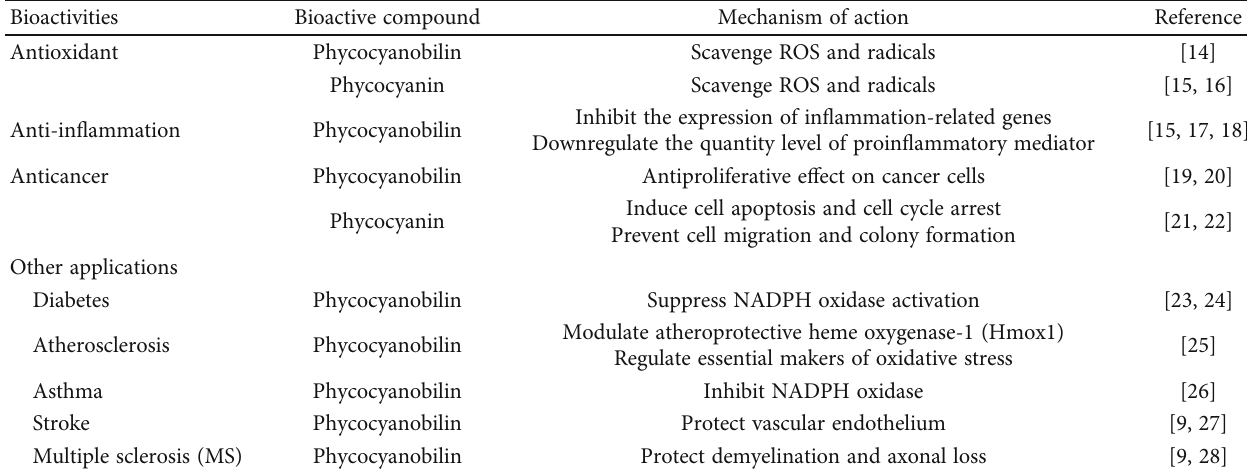
Table 1: The bioactivities of phycocyanobilin and